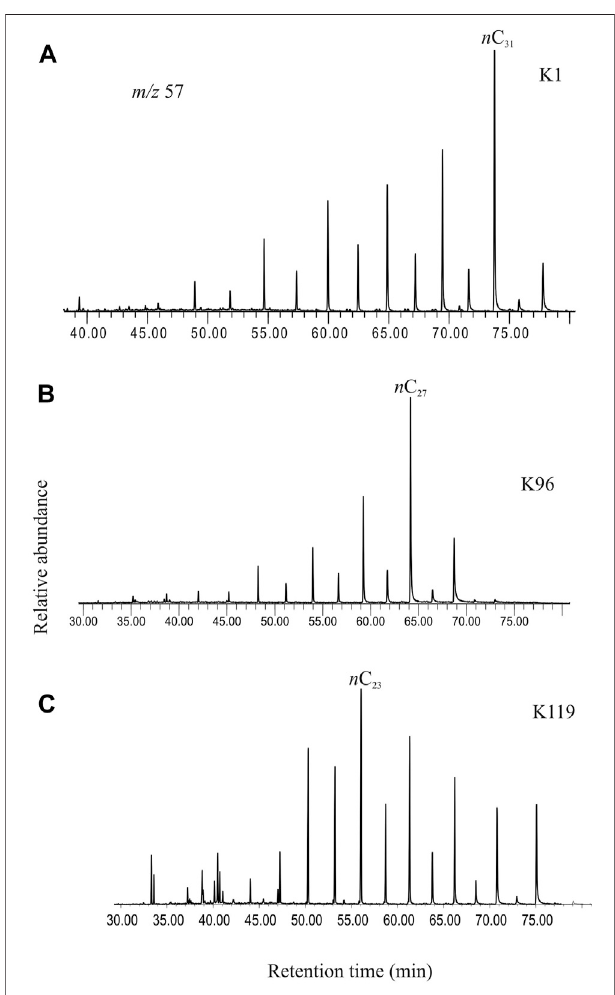
FIGURE3|(A) Selectedionchromatogramat m/z 57showingthechain length distributions of the n -alkanes in the saturated hydrocarbon fraction extracted from the studied sediment (K1, ∼ 369 cal yr BP). (B) Selected ion chromatogram at m/z 57 showing the chain length distributions of the n -alkanes in the saturated hydrocarbon fraction extracted from the studied sediment (K96, ∼ 4842 cal yr BP). (C) Selected ion chromatogram at m/z 57 showing the chain length distributions of the n -alkanes in the saturated hydrocarbon fraction extracted from the studied sediment (K119, ∼ 5655 cal yr BP). A clear shift in the predominant chain length in the sediments from different age intervals is observed. The changeover is a clear signature of response of the ambient vegetation to changing climatic